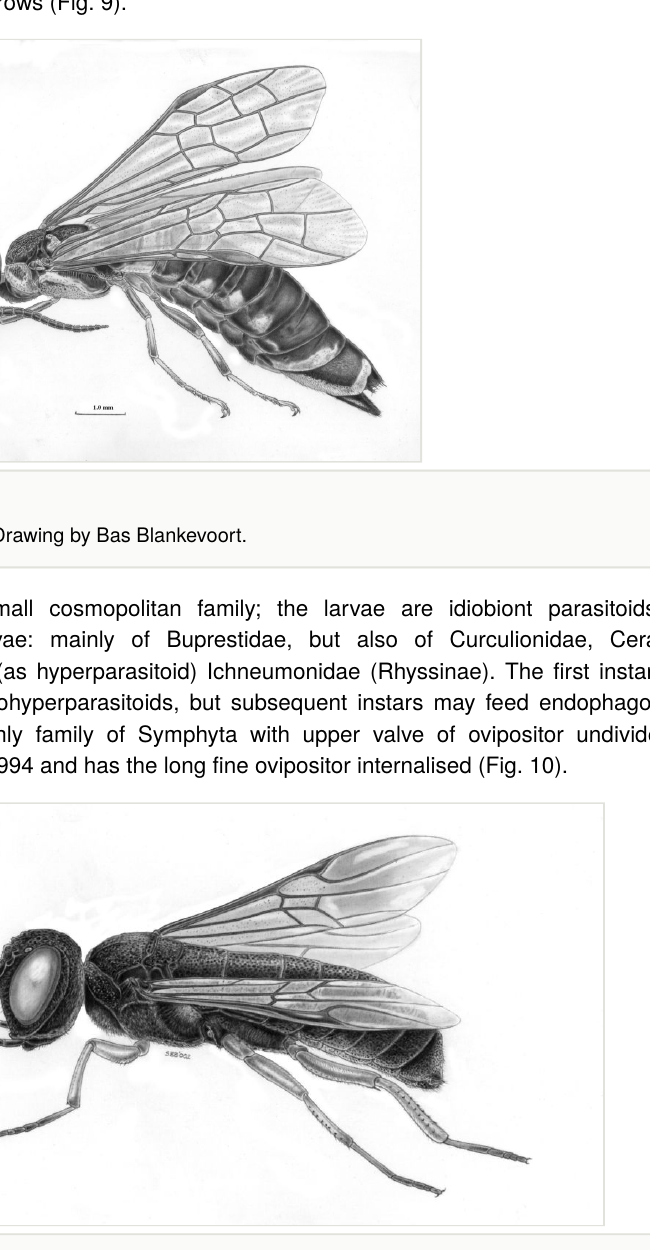
Figure 10. Orussidae Latreille, 1797. Drawing by Bas